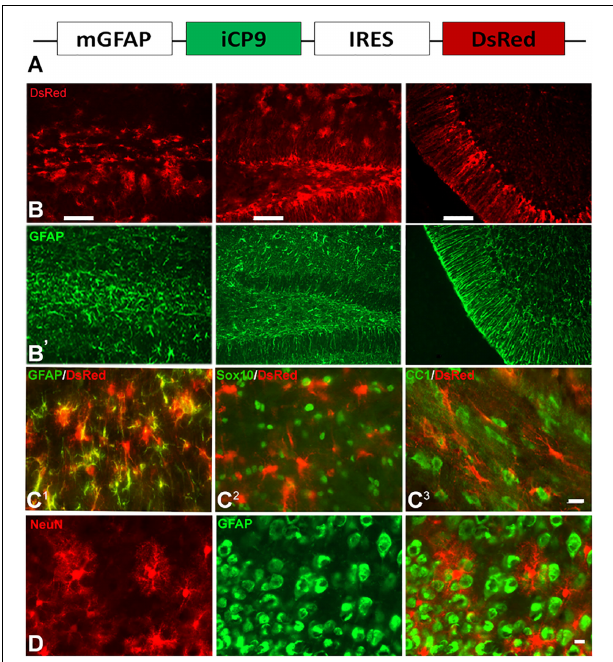
FIGURE 1 | GFAP promoter-driven inducible caspase 9 selectively targets astrocytes. (A) Diagram of the construct used to generate the GFAP-iCP9 transgenic animals. The mouse GFAP promoter (mGFAP) drives expression of iCP9 and an IRES-linked DsRed reporter. (B) DsRed expression was targeted to astrocytes throughout the CNS. Consecutive sections through the corpus callosum, hippocampus and cerebellum of GFAP-iCP9 animals labeled with antibodies to DsRed (top row, B ) and GFAP (bottom row, B’ ). The patterns of labeling were highly aligned. (C) Coronal sections through the corpus callosum of GFAP-iCP9 mice co-labeled with antibodies to DsRed (red) and GFAP (C 1 ) , Sox10 (C 2 ) , and CC1 (C 3 ) in green. The majority of GFAP+ cells expressed DsRed. By contrast, no Sox10 or CC1+ cells expressed detectable DsRed. (D) Coronal section through the frontal cortex of GFAP-iCP9 animals double labeled with antibodies to DsRed (red) and NeuN (green). No NeuN+ cells expressed detectable DsRed. Scale bars: (B) 100 µ m; (C) 20 µ m; (D) 12.5 µ